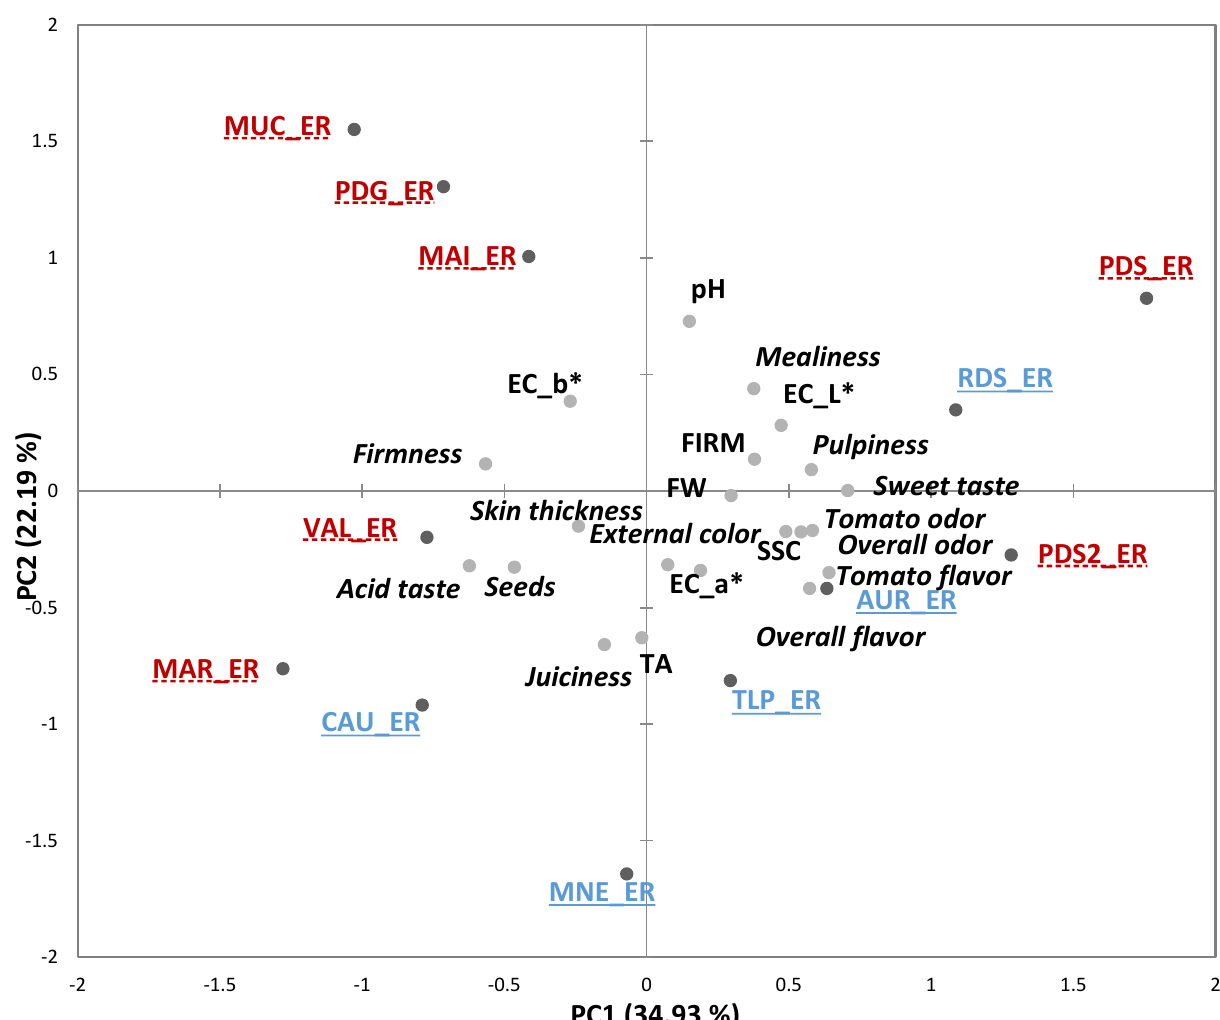
Figure 3. Principal component analysis (PCA) Bi-plot of the sensory and physicochemical parameters of the 12 tomato genotypes grown in Italy and evaluated at the early ripe stage (ER). Sensory descriptors are indicated in italics . Modern varieties are in blue, underlined with solid lines; Traditional varieties are in red, underlined with dashed lines. FW = fruit weight, FIRM = firmness (instrumental), SSC = soluble solids content, TA = titratable acidity. Product codes are listed in Table 1.